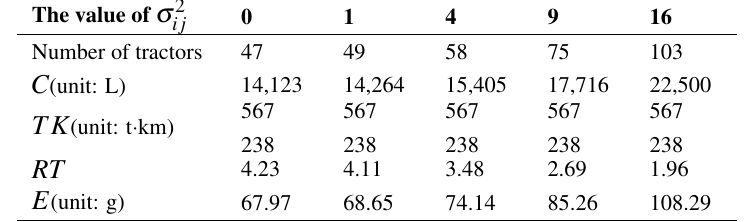
Table 4 Solution results of tractor despatching schemes with different